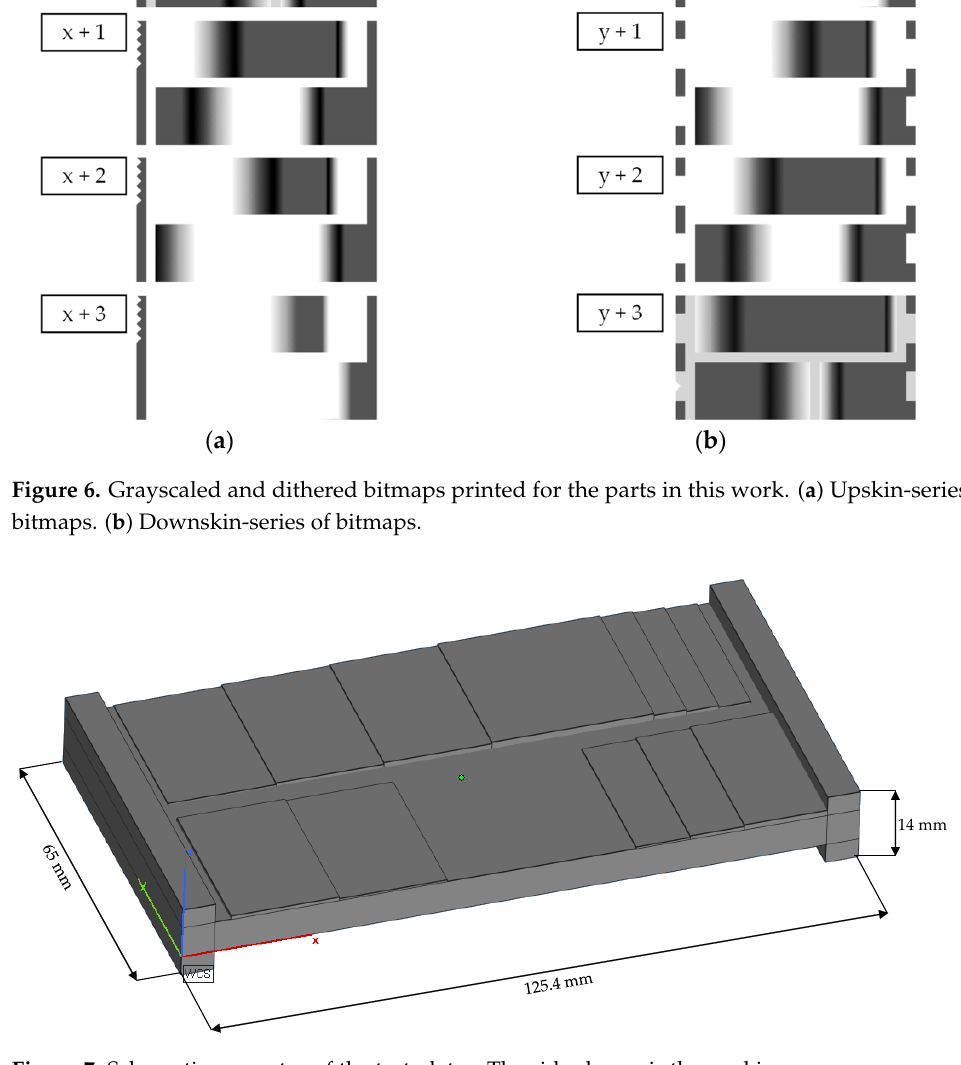
Figure 7. Schematic geometry of the test plates. The side shown is the upskin.